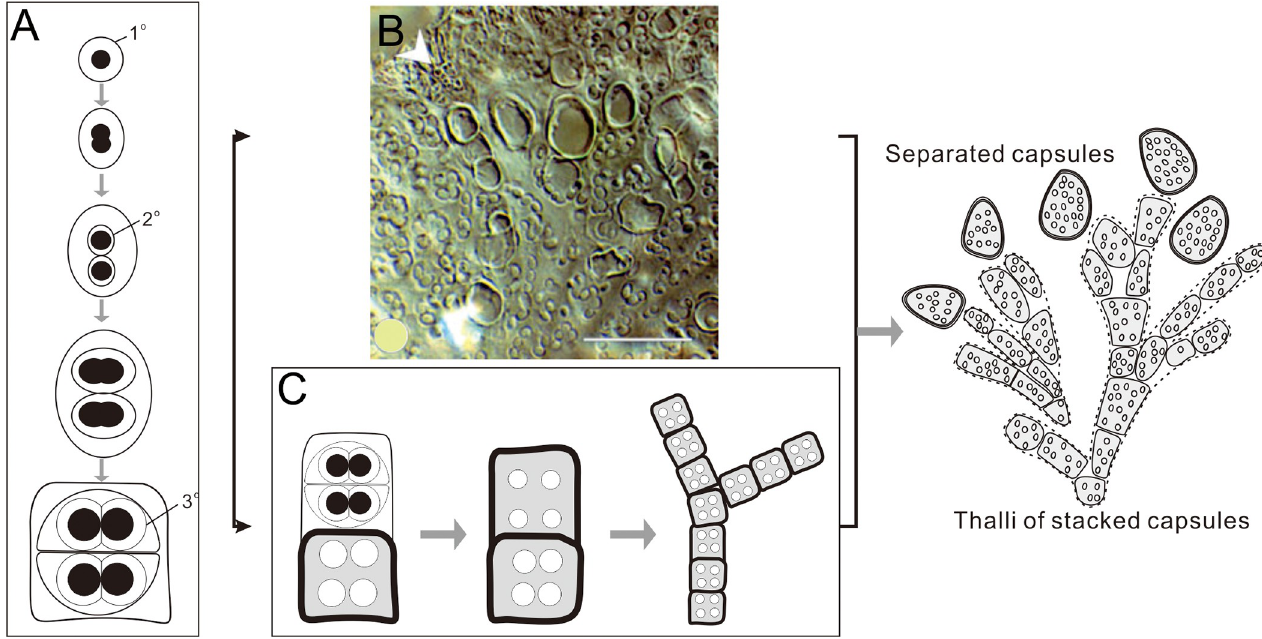
Fig 9. The cell division and assemble model for Epiphyton . (A) Cell division pattern showing two new daughter cells and gelatinous envelopes that are reproduced (modified after Golubic and Hofmann [39]). Envelopes in sequence are marked as 1˚, 2˚, and 3˚. (B) A slightly calcified colony of modern coccoidal cyanobacteria ( Entophysalis sp.) from Lake Van (Turkey) [27] showing how thicker mucilage envelopes stack vertically to be branches. Scale bars: 50 μ m. (C) An apical growth model for Epiphyton implying that dendritic thalli formed by successive growth and the calcification of similar-sized colonies.